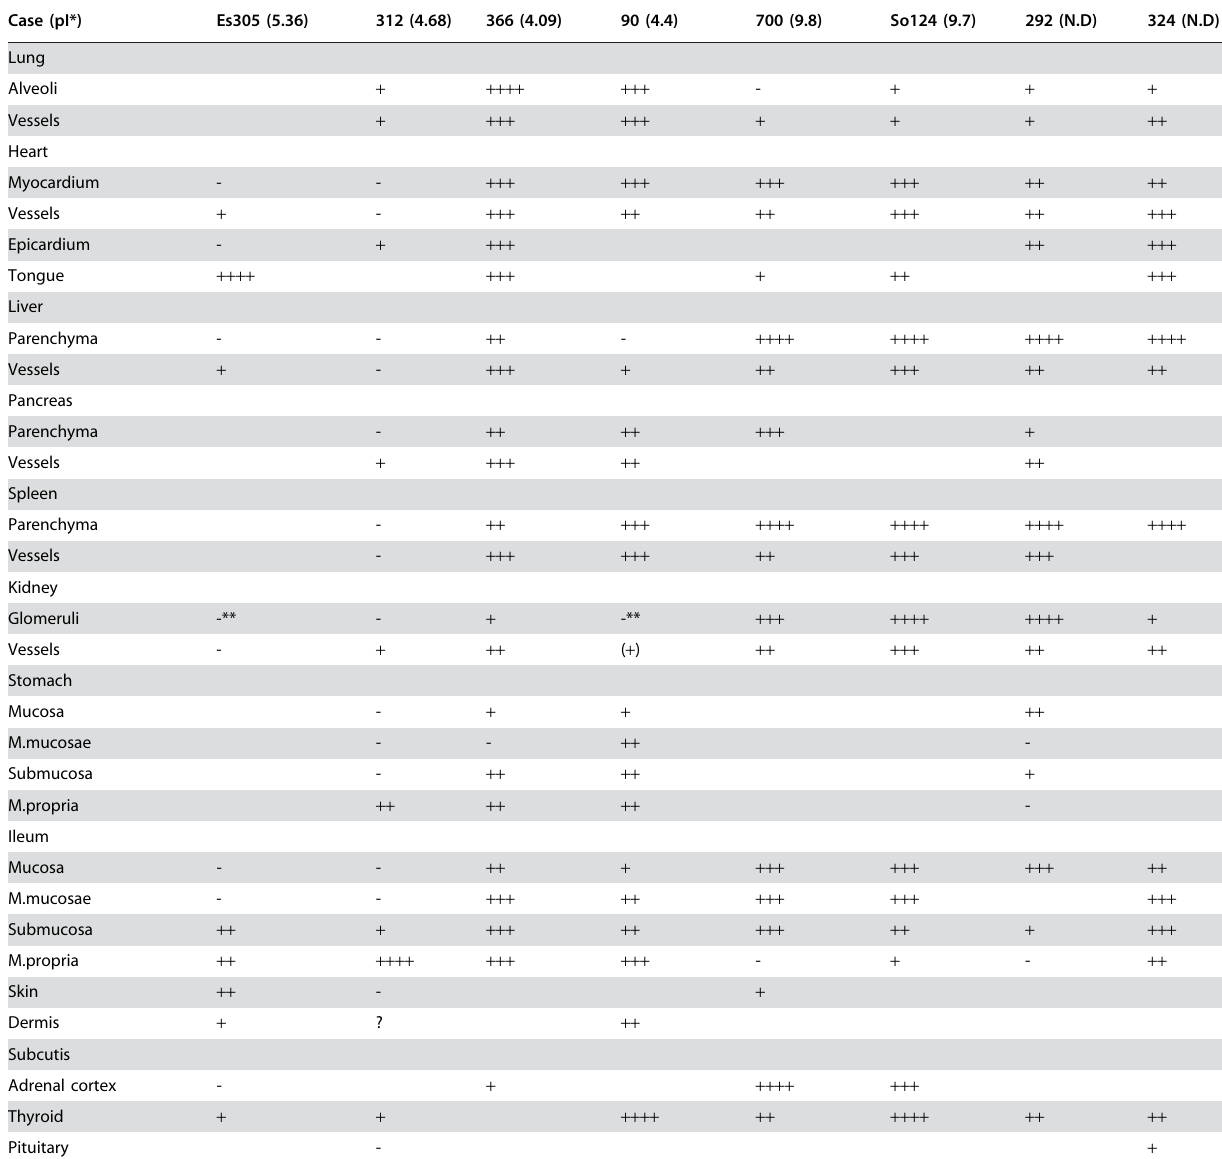
Table 1. Distribution of amyloid in available Congo-red stained sections from the eight studied individuals with systemic AL amyloidosis and in who the amyloid proteins were derived from the k I gene O18-O8 or the k III gene L2-L16. .. ... .... ... ... .... ... ... .... ... ... .... ... ... .... ... ... .... ... ... .... ... ... .... ... ... .... ... ... .... ... ... .... ... ... .... ... ... .... ... ... .... ... ... .